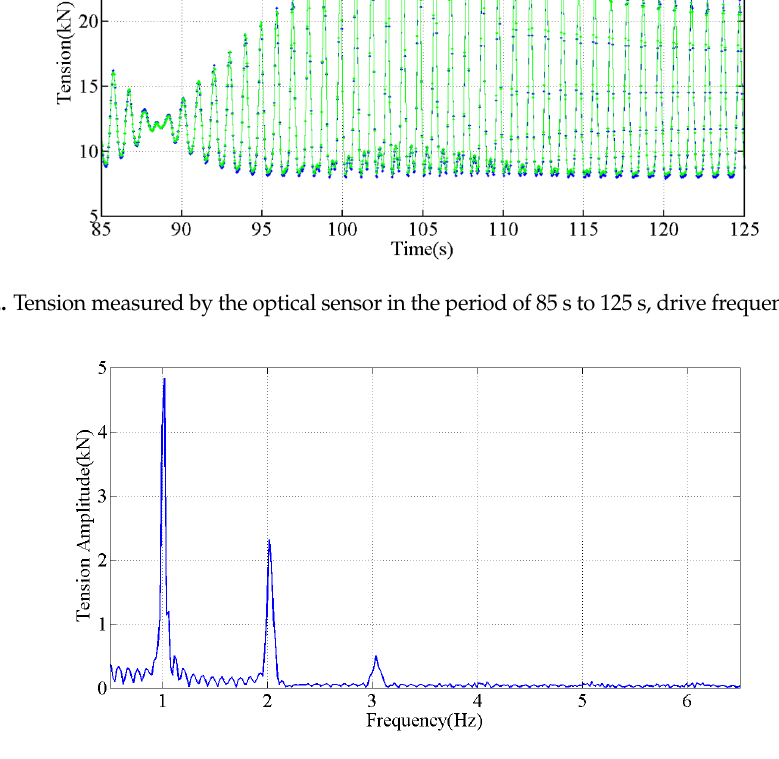
Figure 13. The amplitude spectrum of the tension measured by the optical sensor during the galloping (85 s to 125 s), drive frequency is 1.02 Hz, x-axis limits is 0.5 Hz to 6.5 Hz. The amplitudes and frequencies of a transmission overhead lines change in an actual galloping accident induced by wind conditions. In the second experiment, the drive frequency was set to 0.8 – 2.4 Hz to simulate galloping in the field. The force measured by the optical tension sensor is plotted in Figure 14. The parameters in Equation (4) except the amplitude of the galloping conductor ( a 0 ) and the number of standing wave loops in the span ( n ) are known. The number of standing wave loops can be estimated with the amplitude spectrum of tension